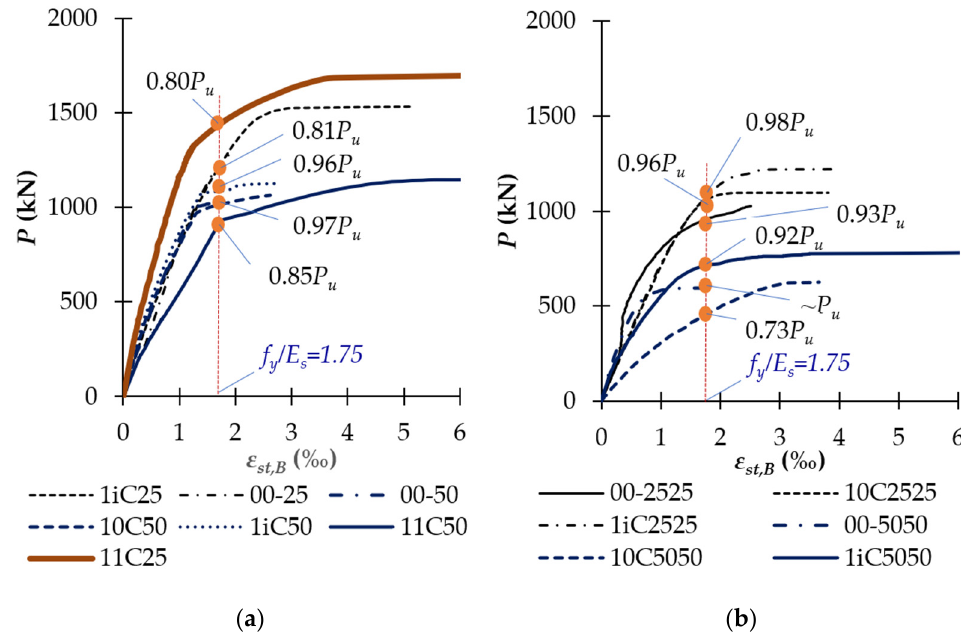
Figure 15. Relationship between the applied load and strain of longitudinal compressive rebars: ( a ) Uniaxially loaded columns; and ( b ) Biaxially loaded columns.